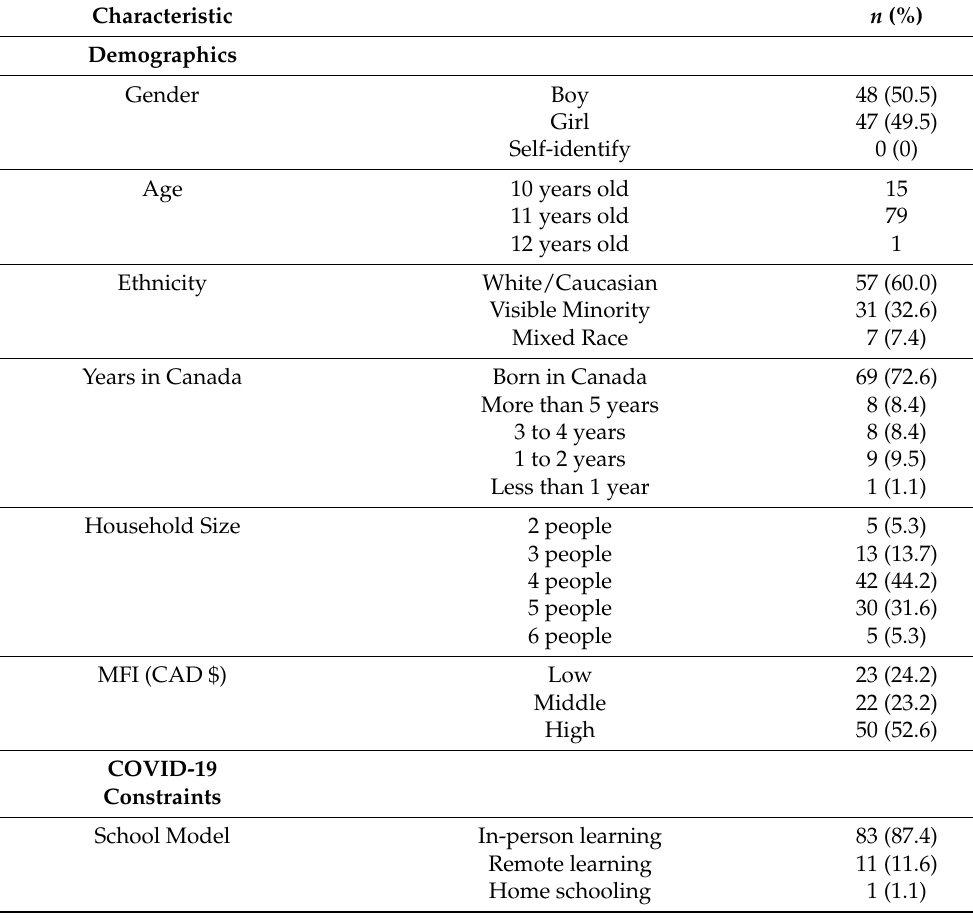
Table 1. Characteristics of the sample population ( n =